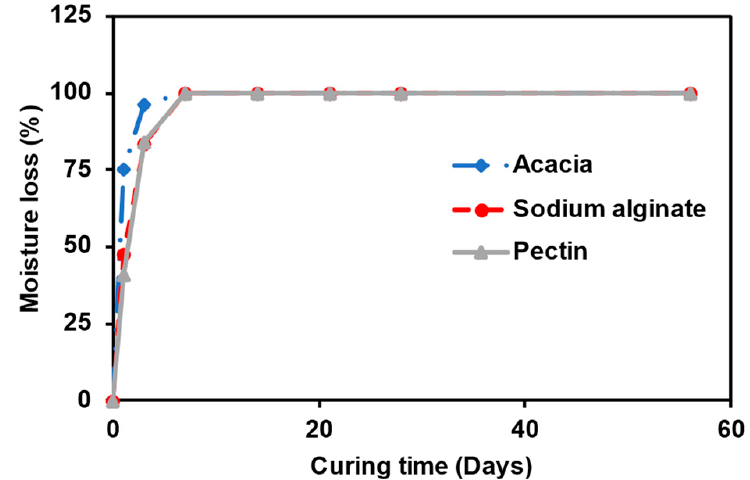
Figure 6. Variation of moisture loss with curing days for 2% biopolymer-modified